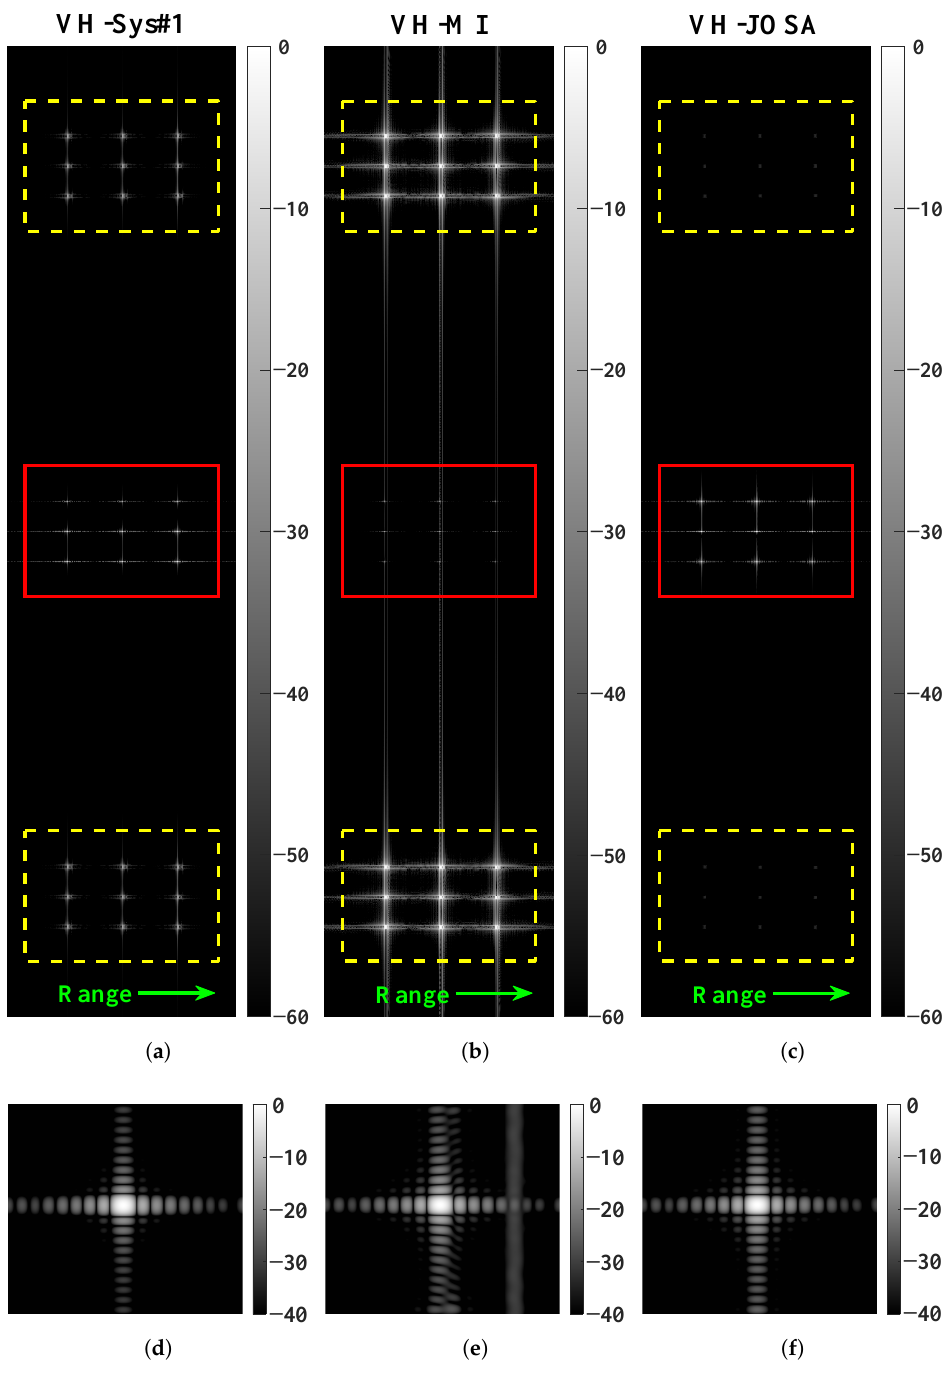
Figure 11. Multi-point imaging results of VH polarization with azimuth ambiguities considered (nine points). System parameters in Table 1 is applied. Amplitude of all the sub-figures is normalized in dB. ( a ) Multi-point simulation result of VH polarization based on system #1 (single-channel ± π /4 quad-pol SAR); ( b ) points simulation result of VH polarization based on system #2 (multichannel ± π /4 quad-pol SAR), reconstructed via the conventional MI method; ( c ) points simulation result of VH polarization based on system #2 (multichannel ± π /4 quad-pol SAR), reconstructed via the proposed JOSA method. Points marked with solid red rectangle in ( a – c ) represent the desired targets, while the points in yellow dashed rectangle represent the fake targets introduced by ambiguities. ( d – f ) give the up-sampled imaging results of the desired targets (points in the upper-left corner) in ( a – c ),